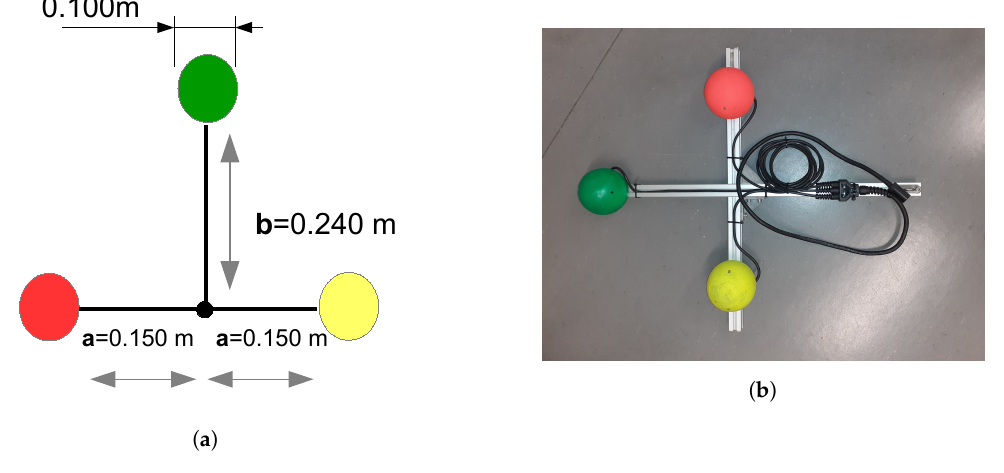
Figure 2. The hybrid target. ( a ) The Target dimensions: different distances on the two axes. ( b ) The developed hybrid Target: the interior lighting intensity is controllable from the docking